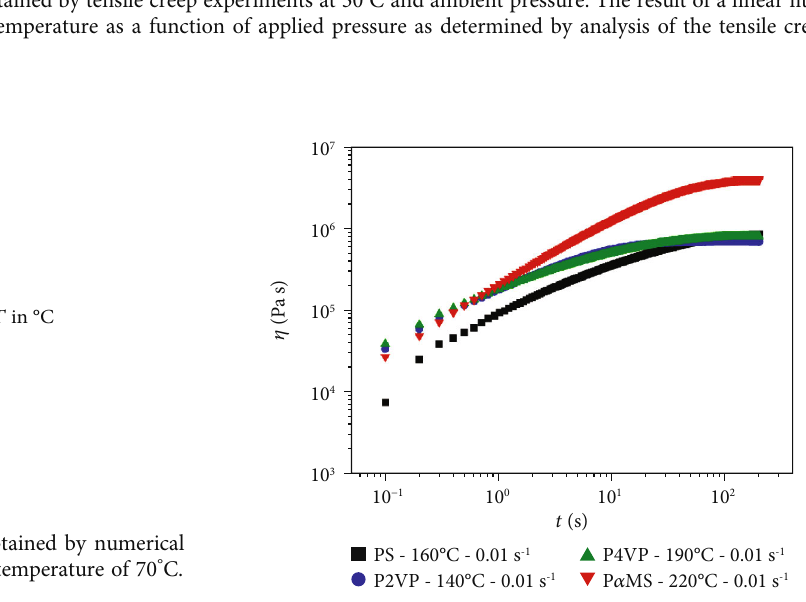
Figure 12: Results of stress-growth experiments at a shear rate of 0.01 s -1 and ambient pressure (1 bar). The measurement temperature is indicated. The polymers are polystyrene, poly(2- vinylpyridine), poly(4-vinylpyridine), and poly( α -methyl